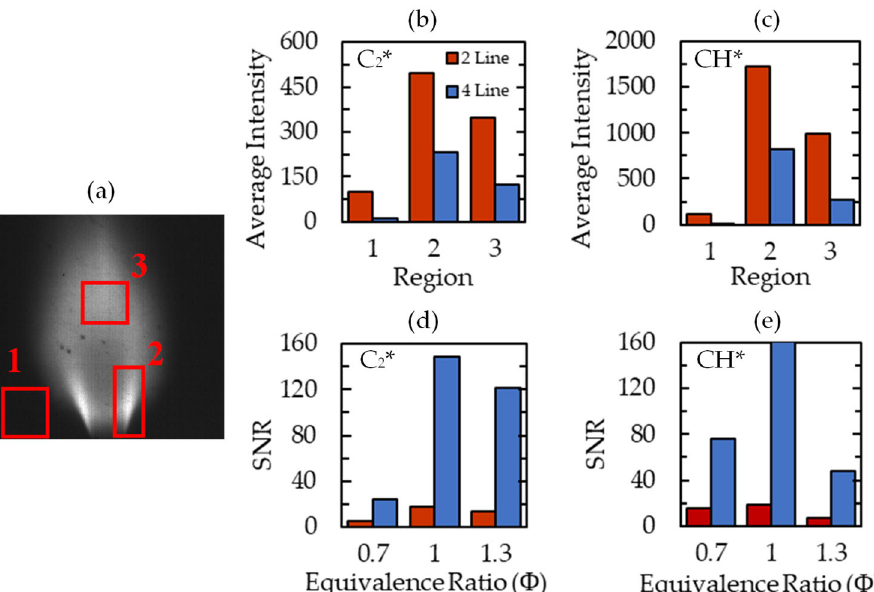
Figure 6. Average signal intensities and signal-to-noise ratio. ( a ) Average C 2 * signal for Φ = 0.7 case with labeled regions of interest, ( b ) average C 2 * intensity in ROI, ( c ) average CH* intensity in ROI, ( d ) C 2 * signal-to-noise ratio for Φ = 0.7, 1.0, and 1.3 cases, and ( e ) CH* signal-to-noise